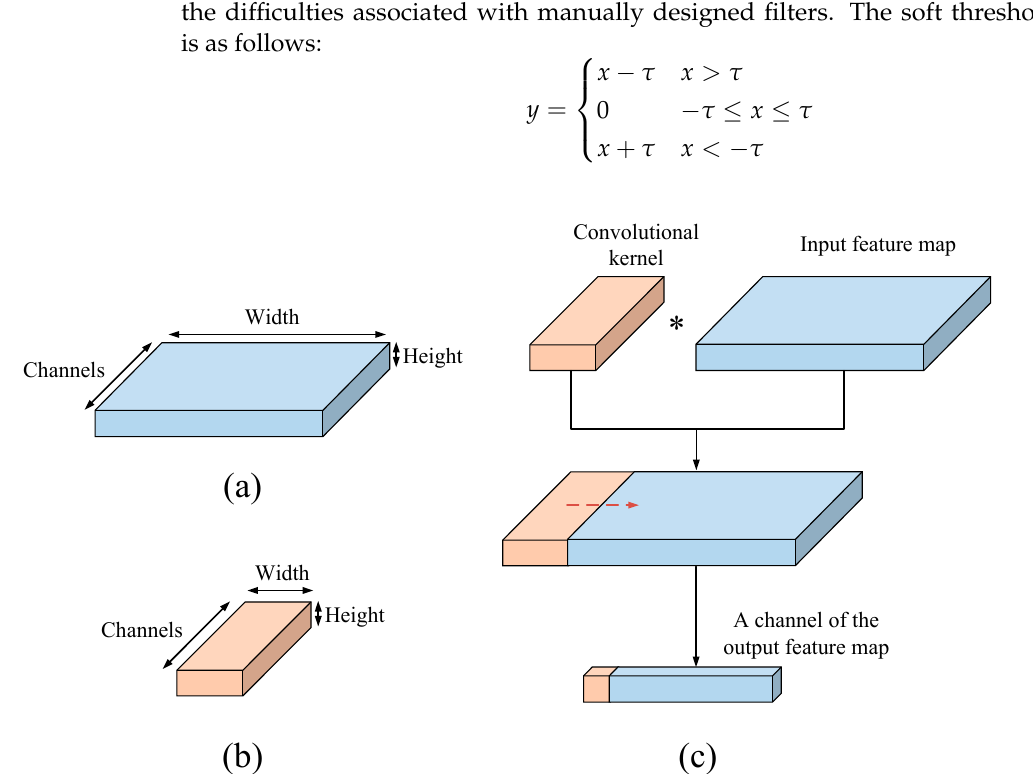
Figure 1. One-dimensional convolution, ( a ) input features, ( b ) convolutional kernel, and ( c ) the 1D convolution process.